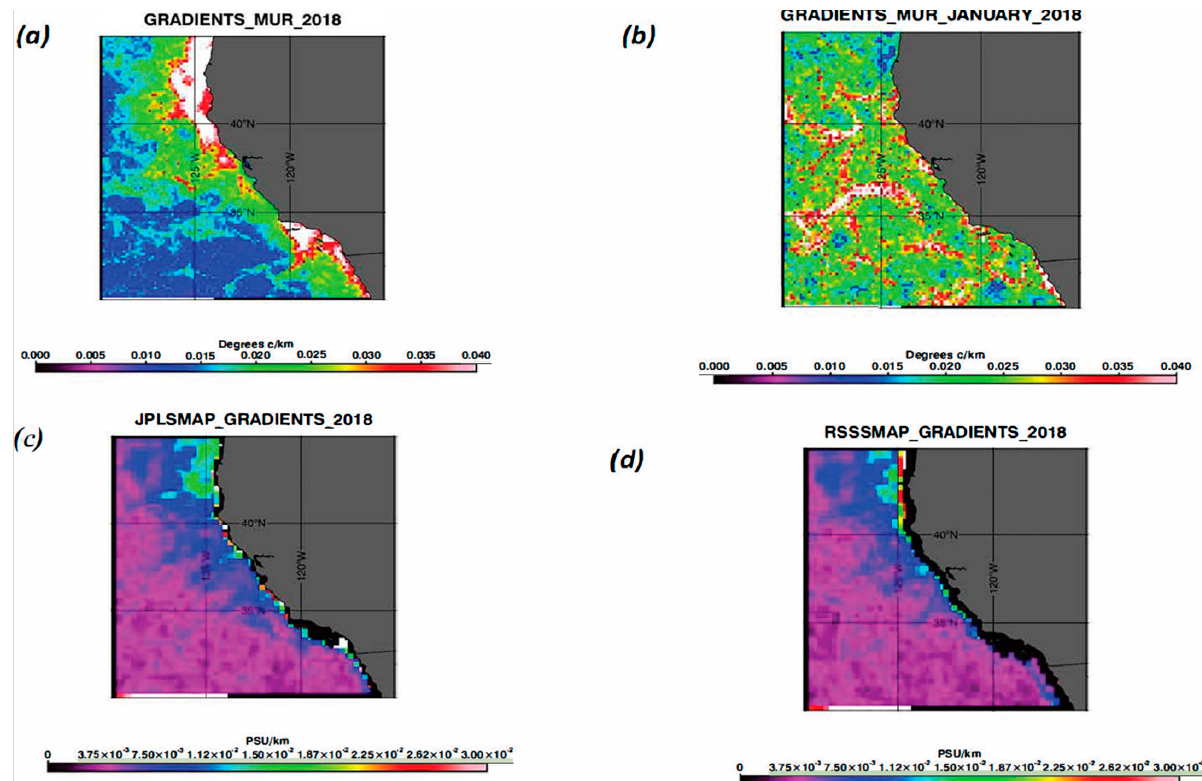
Figure 1. ( a – d ). ( a ) MUR derived mean SST gradients between June 2018 through September 2018, ( b ) MUR derived mean SST gradients for January 2018, ( c ) JPL SMAP derived SSS gradients June